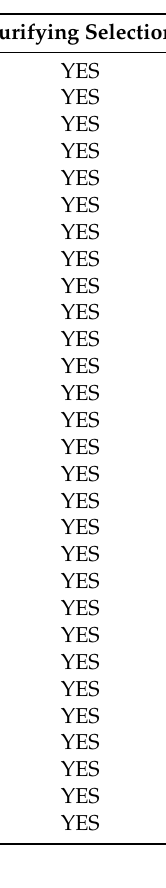
Table 1. Ka / Ks values and the divergence time of duplicate gene pairs in seven tested species.